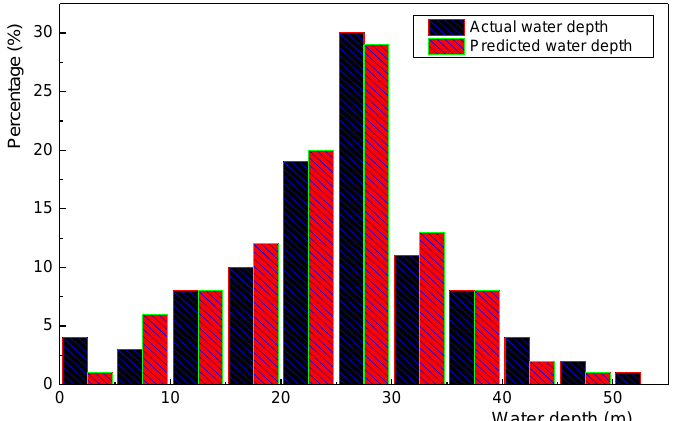
Figure 8. Actual and predicted water depth data from Nantong Port.